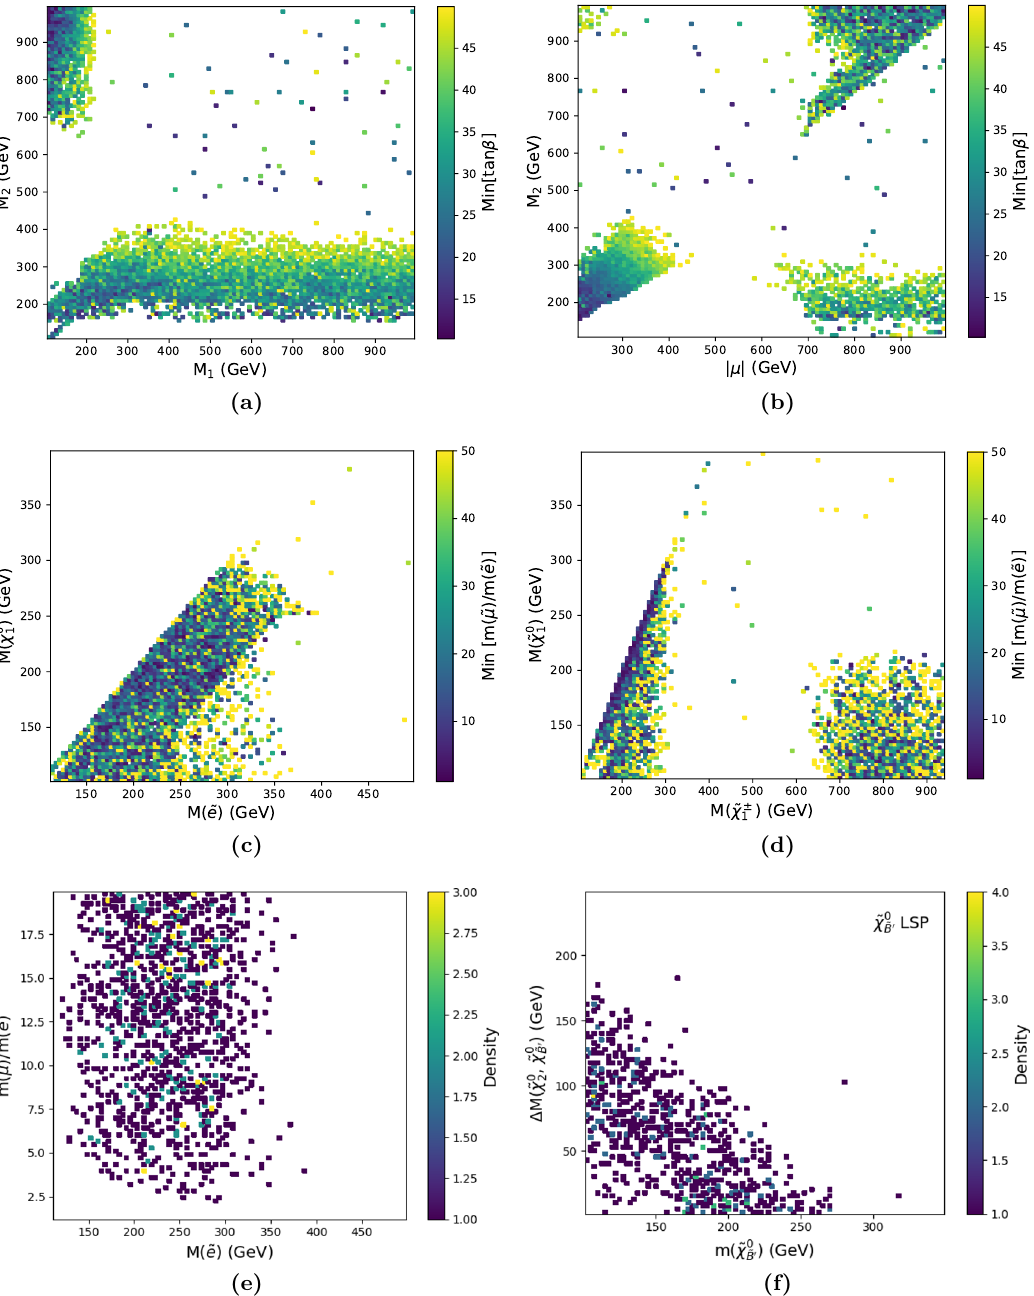
Figure 4. Parameter regions explaining both electron and muon anomalous magnetic moment observations: 4(a) shows the allowed regions in M 1 - M 2 bins with the colors denoting minimum tan β encountered in the respective bins. Figure 4(b) plots the allowed bins of | µ | and M 2 with the same attribute for the color. 4(d) and 4(c) plot the viable spectrum of the lightest neutralino, chargino and slepton masses with the minimum encountered smuon to selectron mass ratio denoted by the colors. 4(e) shows the allowed selectron masses against the ratio of smuon to selectron masses, the colors denote the density of points. 4(f) shows parameter points where the LSP is ˜ B 0 dominated against the mass gap between it and the